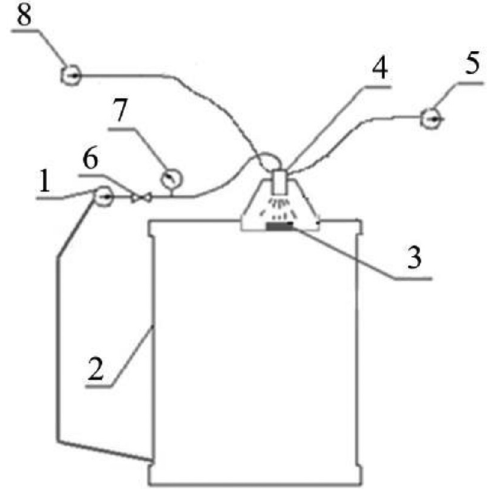
Fig. 1. Scheme of surface cleaning using cavitating water jet: 1 – water pump ( fl ow rate 18 l/min, max. pressure 140 bar); 2 – water tank; 3 – surface being cleaned; 4 – cavitation generating head; 5 – vacuum pump ( fl ow rate 240 l/min); 6 – valve; 7 – pressure gauge; 8 – air blower ( fl ow rate 150 l/min, pressure 1